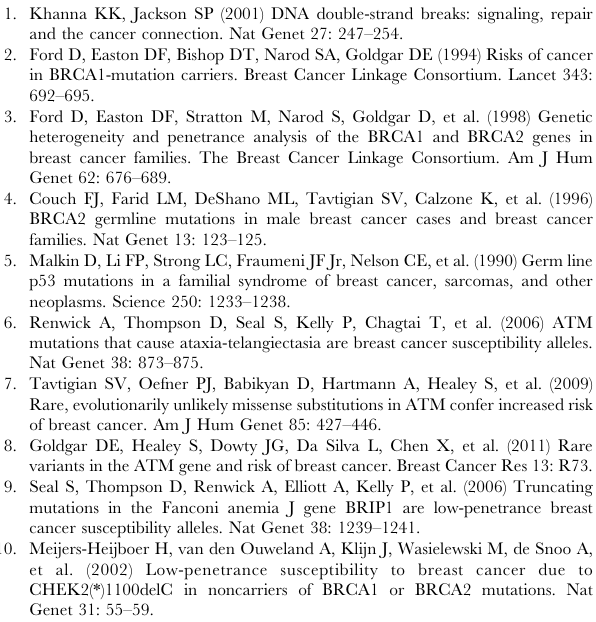
Table S1 Stratified analyses of RAD51 non-coding SNPs on breast cancer risk in the